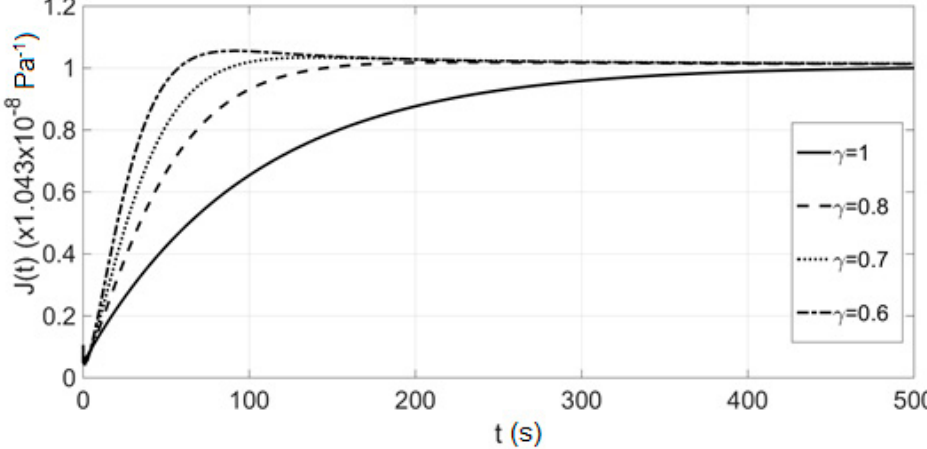
Figure 8. Variation of the creep compliance versus time for γ = 1, 0.98, 0.96, 0.94 in the initial space.